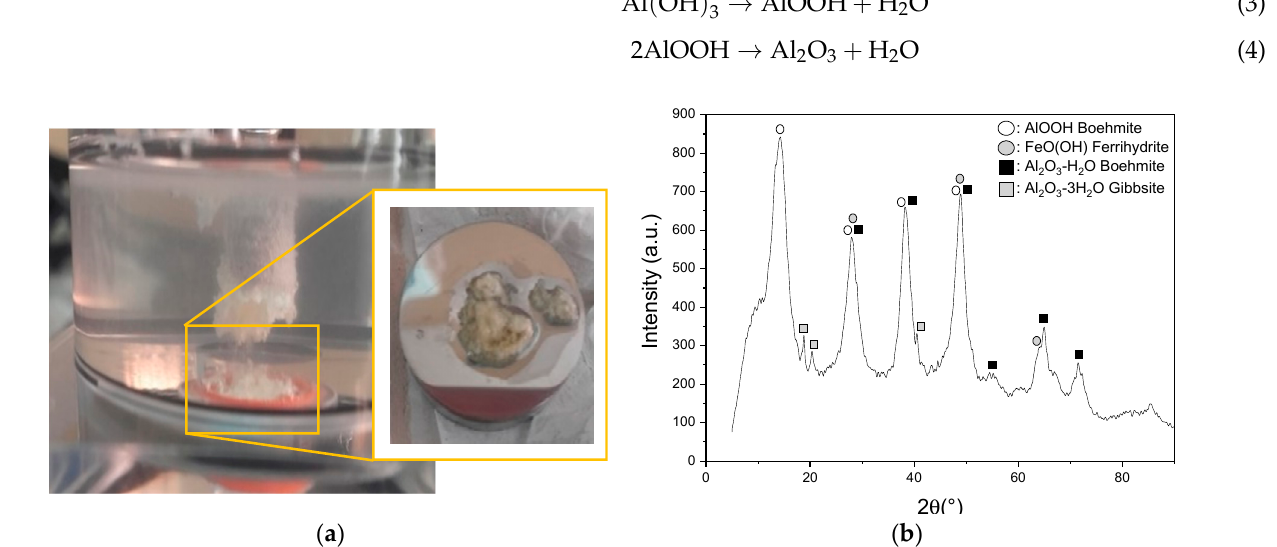
Figure 2. ( a ) Precipitate formed on the 304L SS samples during NaAlO 2 treatments, and ( b ) XRD pattern of precipitate from ( a ).